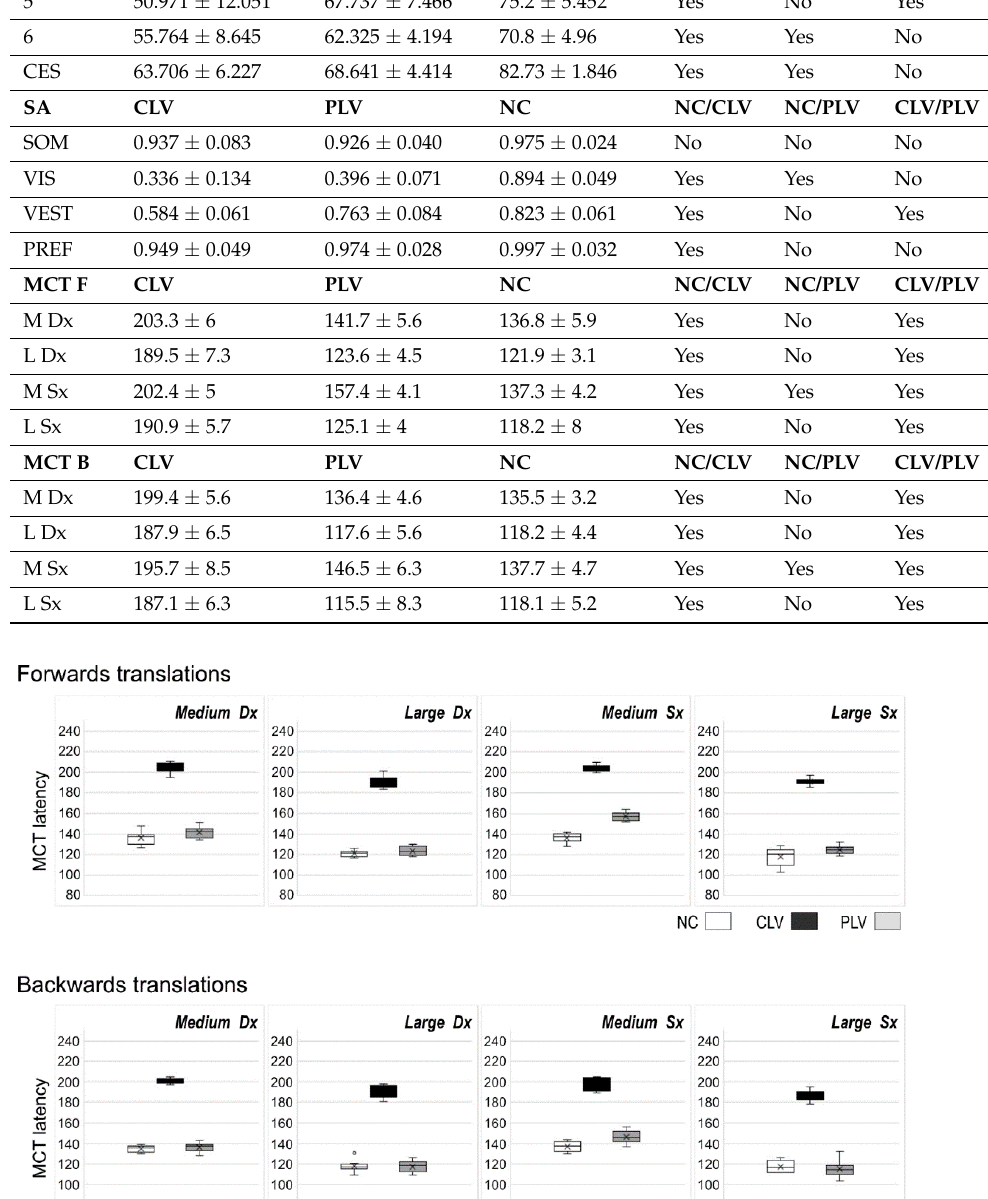
Figure 4. Mean MCT amplitudes for the medium/large forward and backward linear-translations. NC: Normal Control; CLV: central low vision PLV: peripheral vision loss.